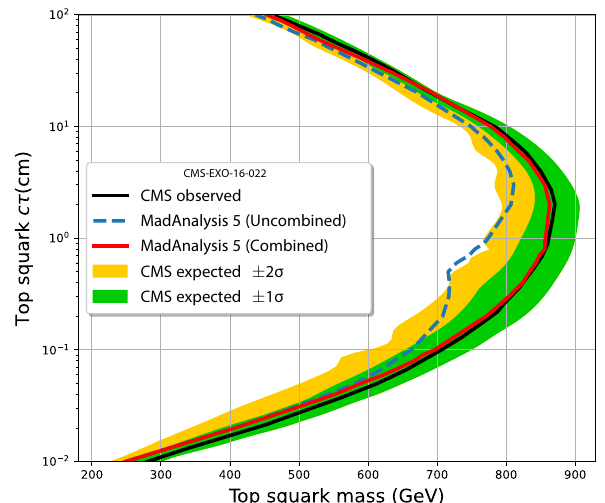
Fig. 3 Exclusion contours in the ( m ˜ t , c τ) as obtained using our Mad- Analysis 5 (SFS) implementation (red), and the CMS official exclu- sion curve (black, with the 1 σ and 2 σ bands given in green and